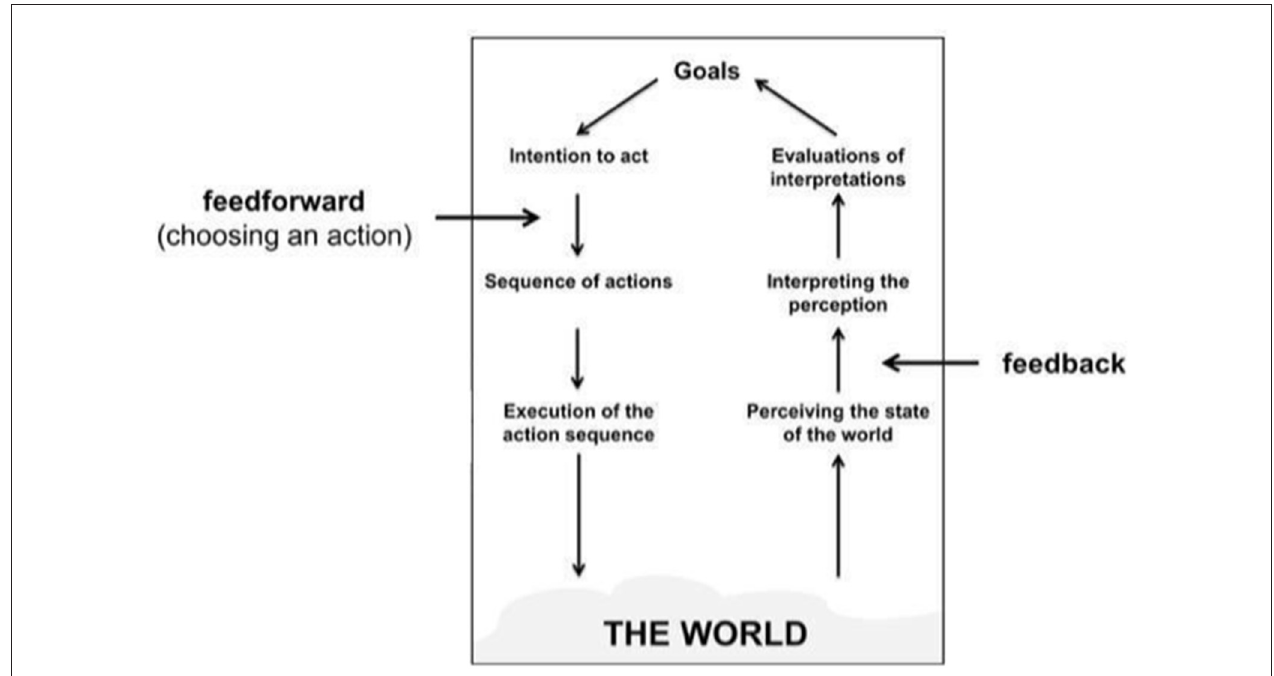
FIGURE 2 | The position of feedforward and feedback in Norman’s Stages of Action model (Image adapted from Vermeulen et al., 2013).